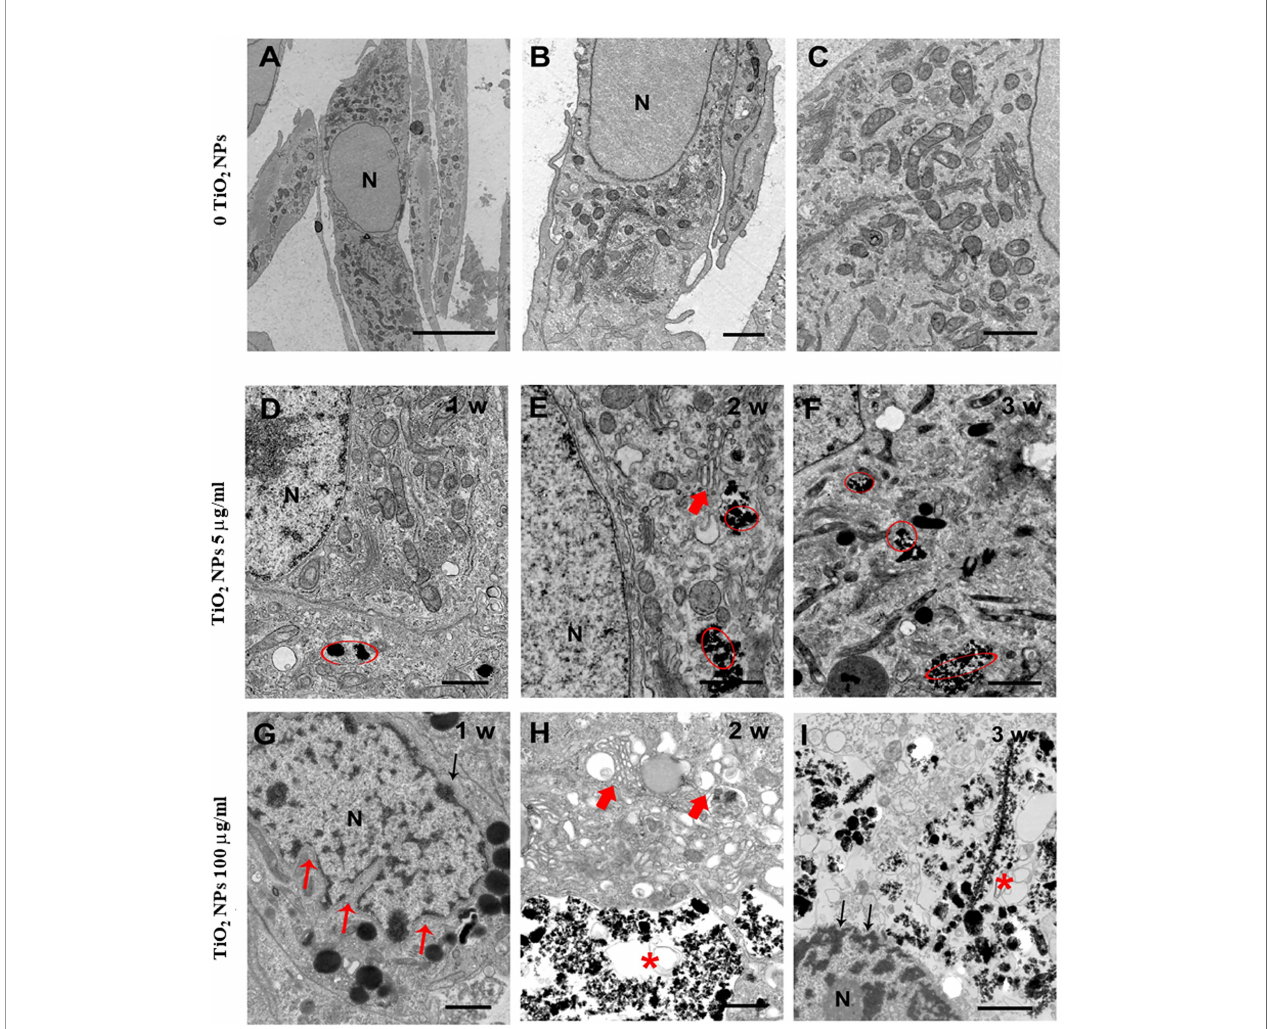
FIGURE 3 | Representative TEM images of unexposed SCs (A – C) and after treatment with TiO 2 NPs at 5 and 100 µg/ml for 1, 2, and 3 weeks of exposure (D – I) . (A – C) Elongated oval or spindle-shaped SCs containing quite large nuclei (N) and abundant mitochondria [better visible at higher magni fi cation in (C) ]. (D – I) SCs after treatment with TiO 2 NPs at 5 µg/ml (D – F) and 100 µg/ml/L (G – I) for 1, 2, and 3 weeks of exposure (chronic). Red circles and asterisks indicate TiO 2 NPs deposition. Small red arrows indicate nuclear membrane invaginations. Large red arrows indicate enlarged endoplasmic reticulum. Black arrows in (I) point to chromatin marginalization. The scale bar corresponds to 5 µm for (A) , 2 µm for the (B) , and 1 µm for (C – I)